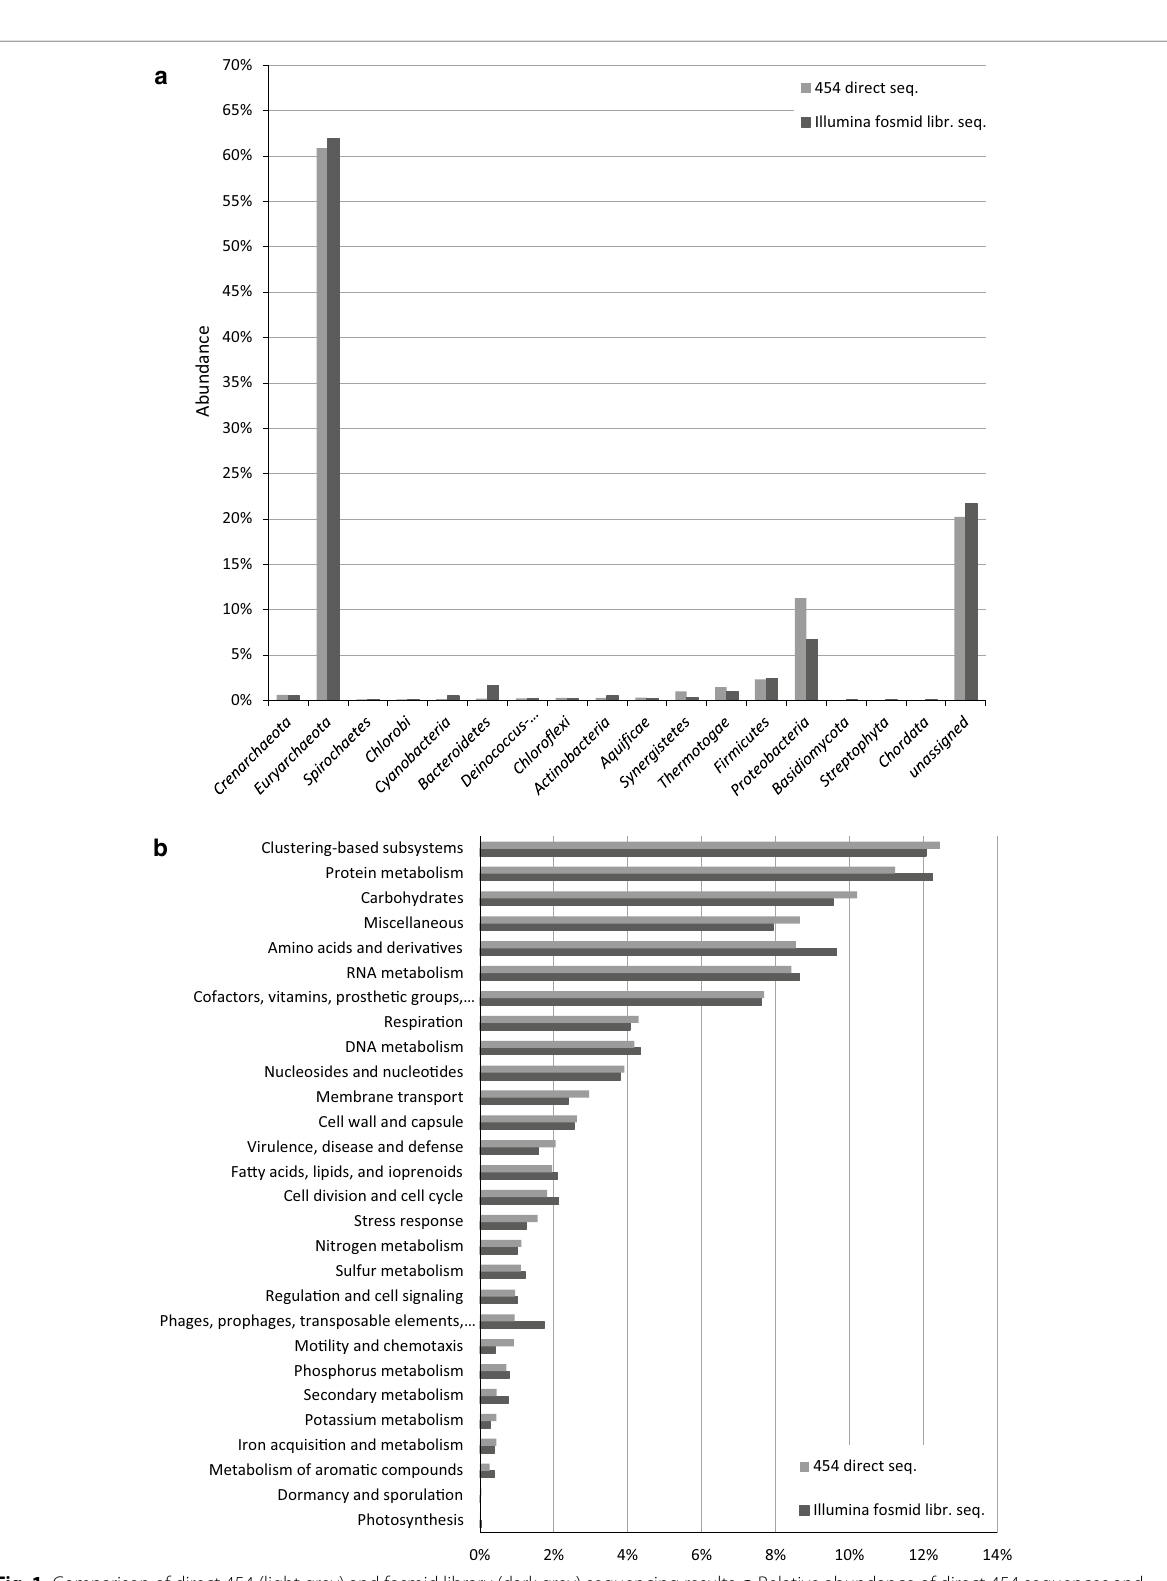
Fig. 1 Comparison of direct 454 (light grey) and fosmid library (dark grey) sequencing results. a Relative abundance of direct 454 sequences and fosmid metagenomic library Illumina sequences at the phylum level, and b based on functional classification as compared to the SEED database (Overbeek et al.